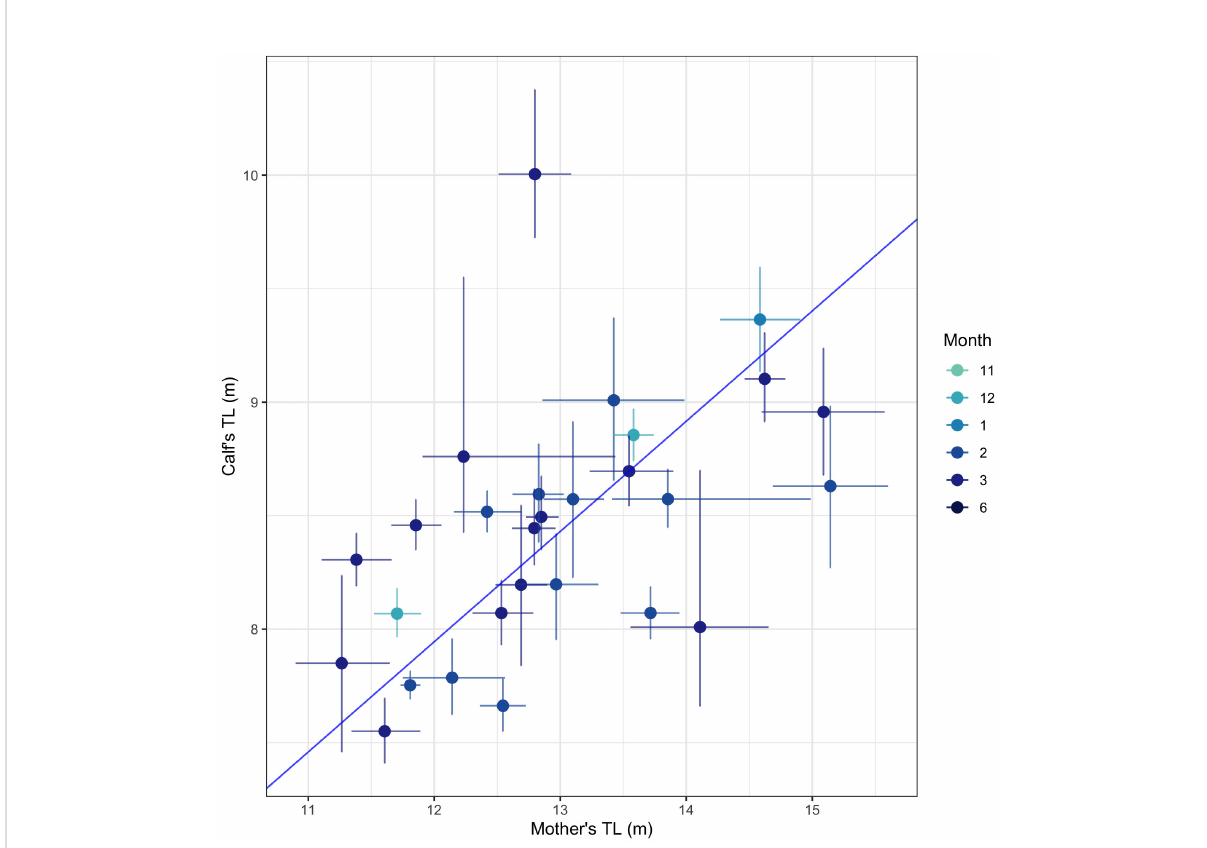
FIGURE 5 The total length (TL) between mother-calf pairs. Each point represents the mean of the posterior predictive distribution for TL for each mother and calf in a mother-calf pair. The solid lines represent the uncertainty as the 95% highest posterior density (HPD) intervals. The blue solid line indicates the best fi t from a Deming regression (slope = 0.49 [95% HPD: 0.30, 0.67], intercept = 2.11 [95% HPD: -0.28,